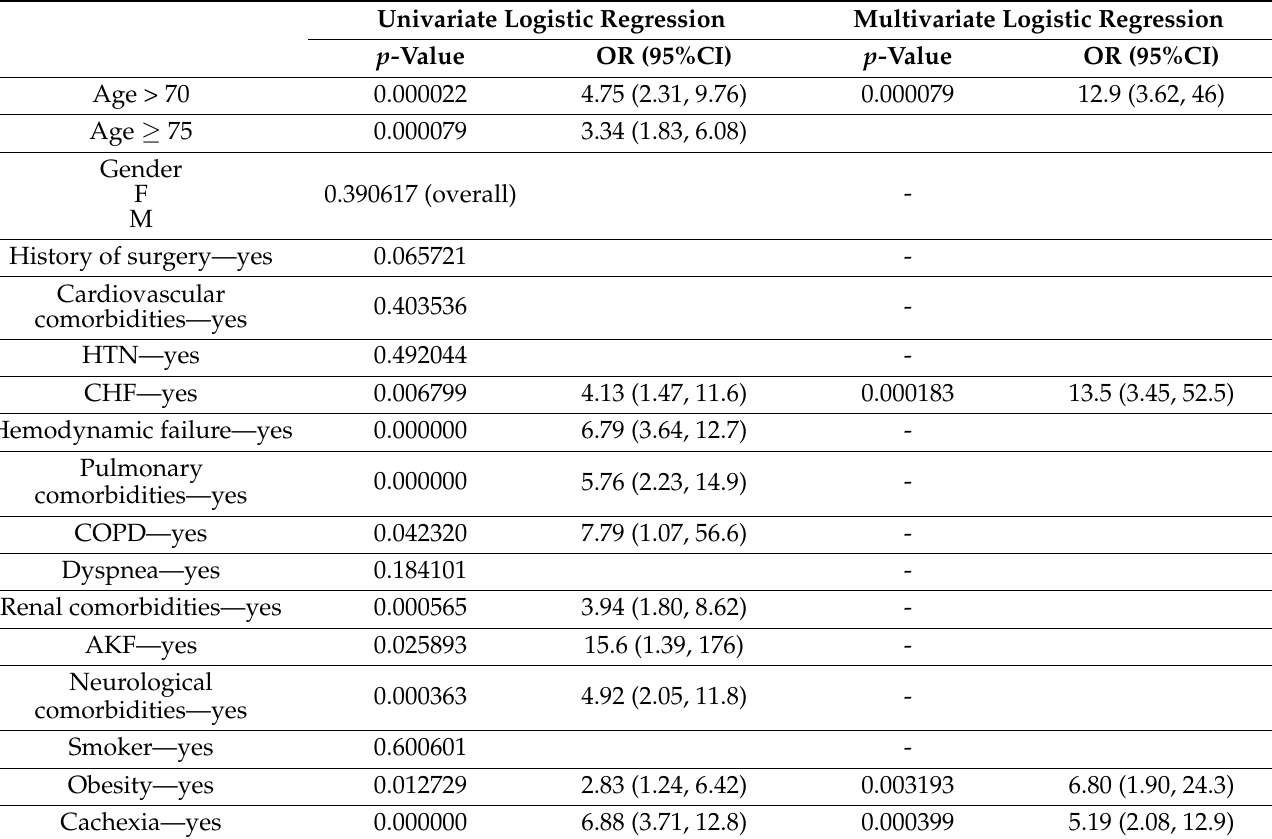
Table 2. Univariate and multivariate logistic regression